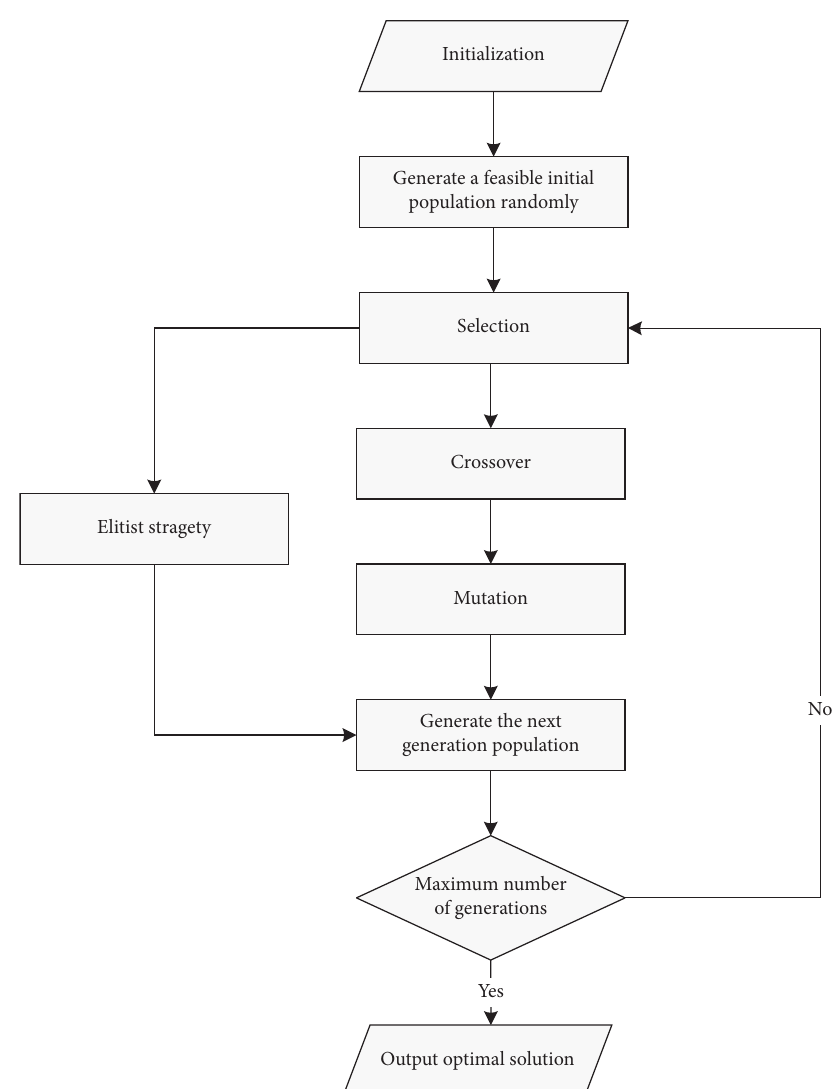
Figure 4: The flowchart of genetic algorithm.